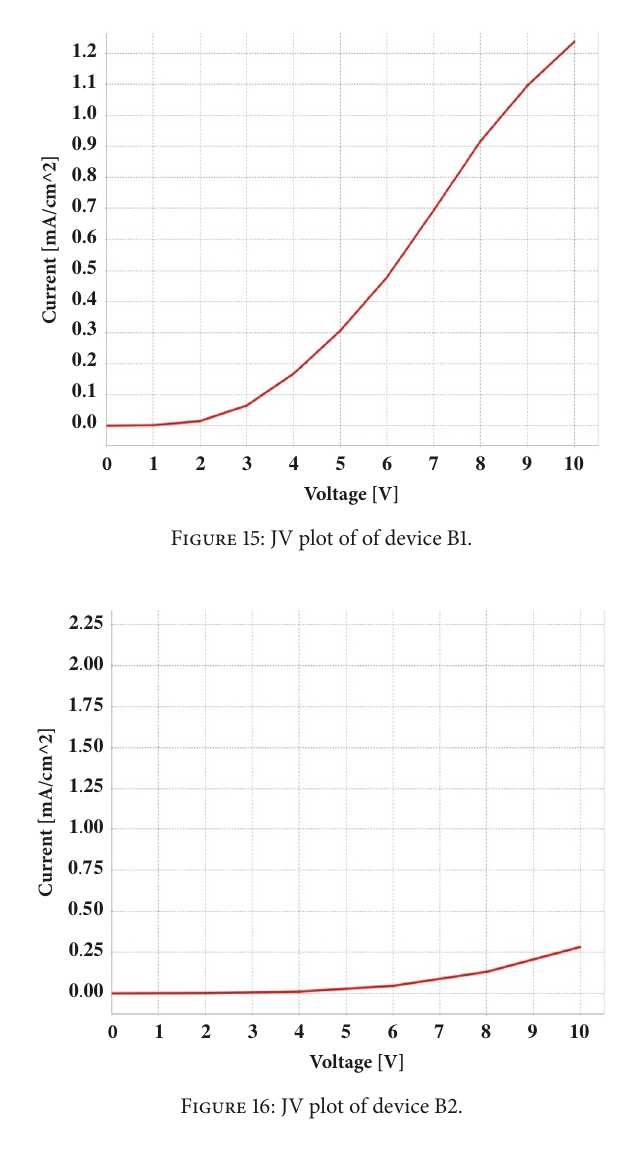
capability of CGL is explained through J-V and C-V plot of tandem device R as shown in Figures 17 and 18,